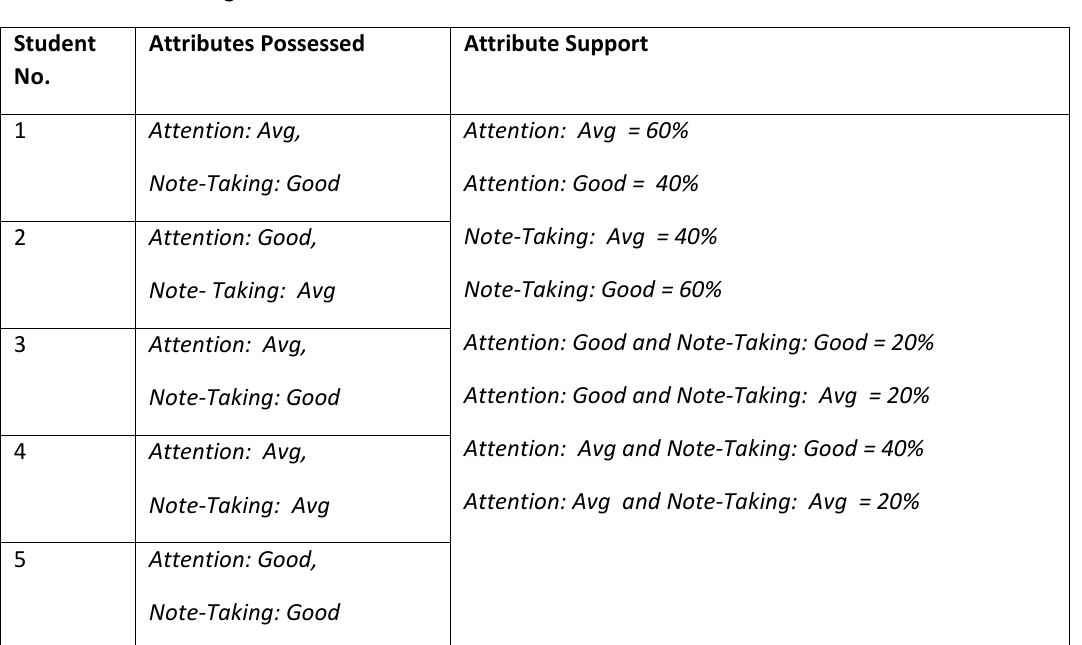
Table 3 Pattern Mining in